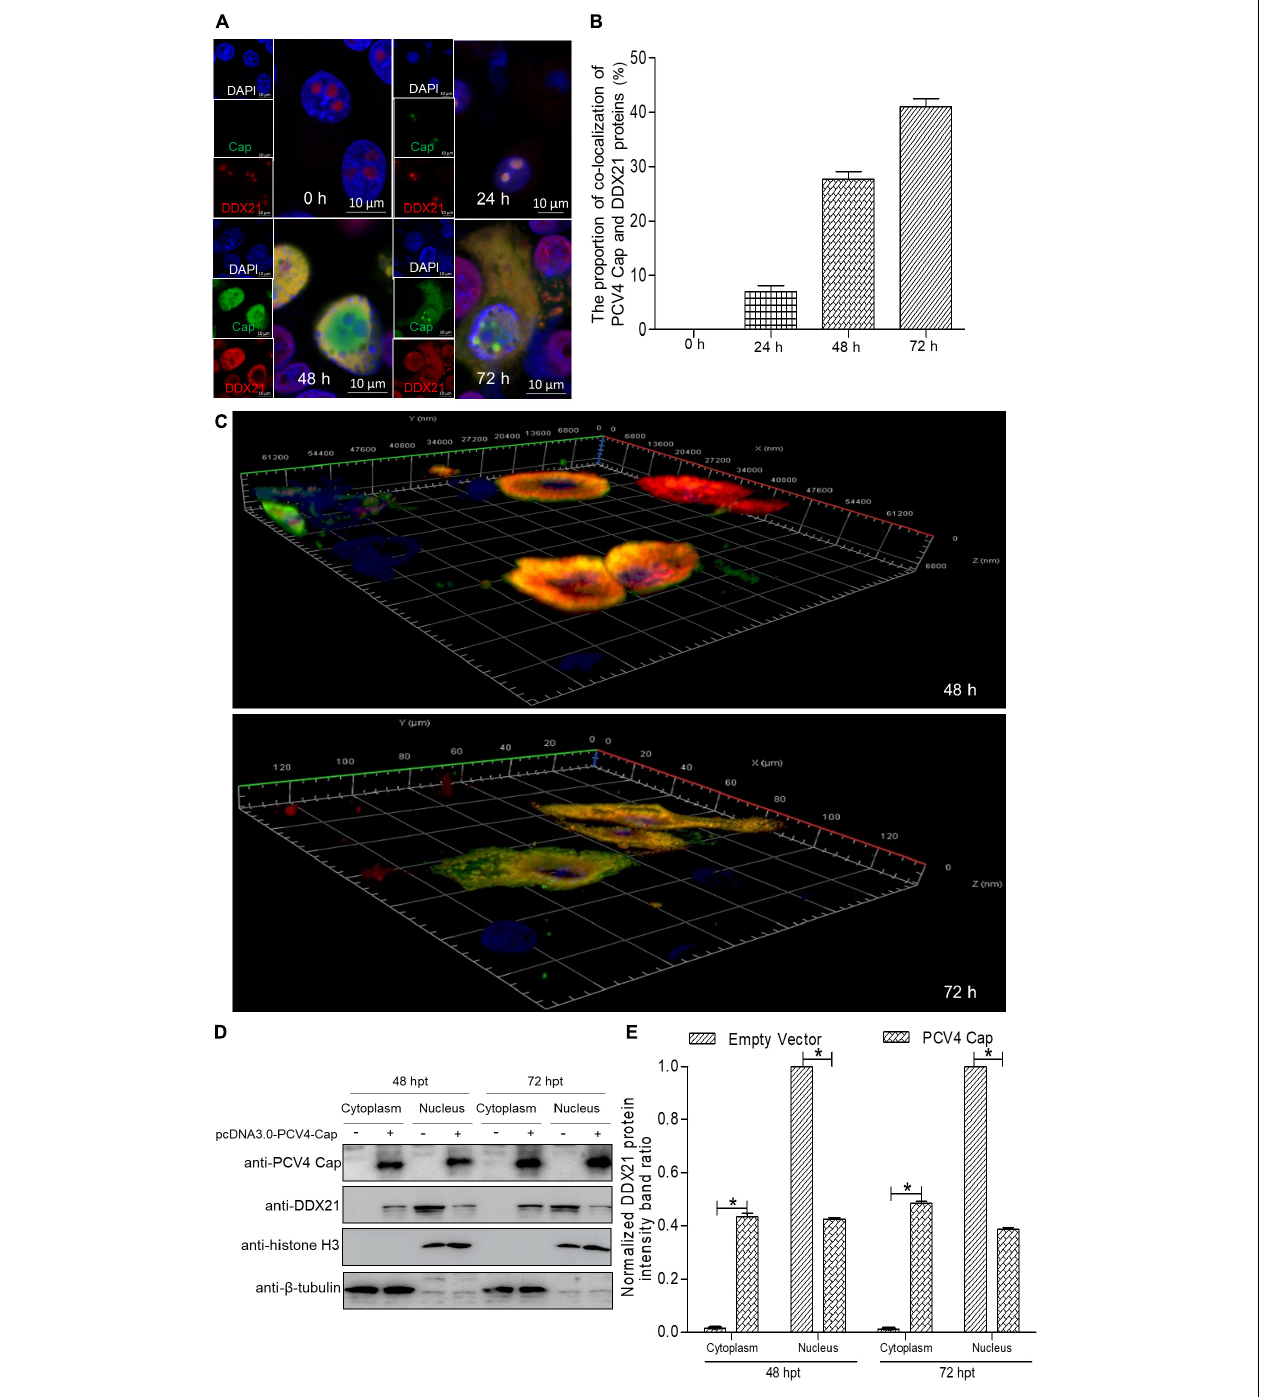
FIGURE 1 | DDX21 relocates from the nucleolus to the cytoplasm induced by PCV4 Cap overexpression. (A) Immunofluorescence analysis of DDX21 localization during PCV4 Cap expression. PK-15 cells were transfected 4.0 µ g of pcDNA3.0-PCV4-Cap plasmid. The cells were fixed at 24, 48, and 72 h post-transfection (hpt) and incubated with the antibodies corresponding PCV4 Cap, and DDX21 followed by the fluorescein isothiocyanate (FITC)-conjugated goat anti-mouse IgG (green) and Alexa Fluor-546 conjugated donkey anti-rabbit IgG (red) secondary antibodies. Nuclei were stained with DAPI (blue) and then observed under a confocal microscope. Scale bar, 10 µ m. (B) The proportion of co-localization of PCV4 Cap and DDX21 proteins was analyzed using ImageJ software at 24, 48, and 72 hpt. (C) The three-layer dimensional confocal stack analysis was performed to verify the co-localization of PCV4 Cap and DDX21 proteins at 48 and 72 hpt. (D) The cell nuclear and cytoplasmic fractions were extracted after PK-15 cells transfected 4.0 µ g of pcDNA3.0-PCV4-Cap plasmid. At 48 and 72 hpt, the protein samples were prepared and analyzed by western blotting using antibodies against PCV4 Cap and DDX21. Histone H3 and β -tubulin served as fractionation quality controls. (E) The DDX21 protein band intensity was analyzed using ImageJ software at 48, 72 hpt. Data are presented as means ± SD of three independent experiments. * p < 0.05.